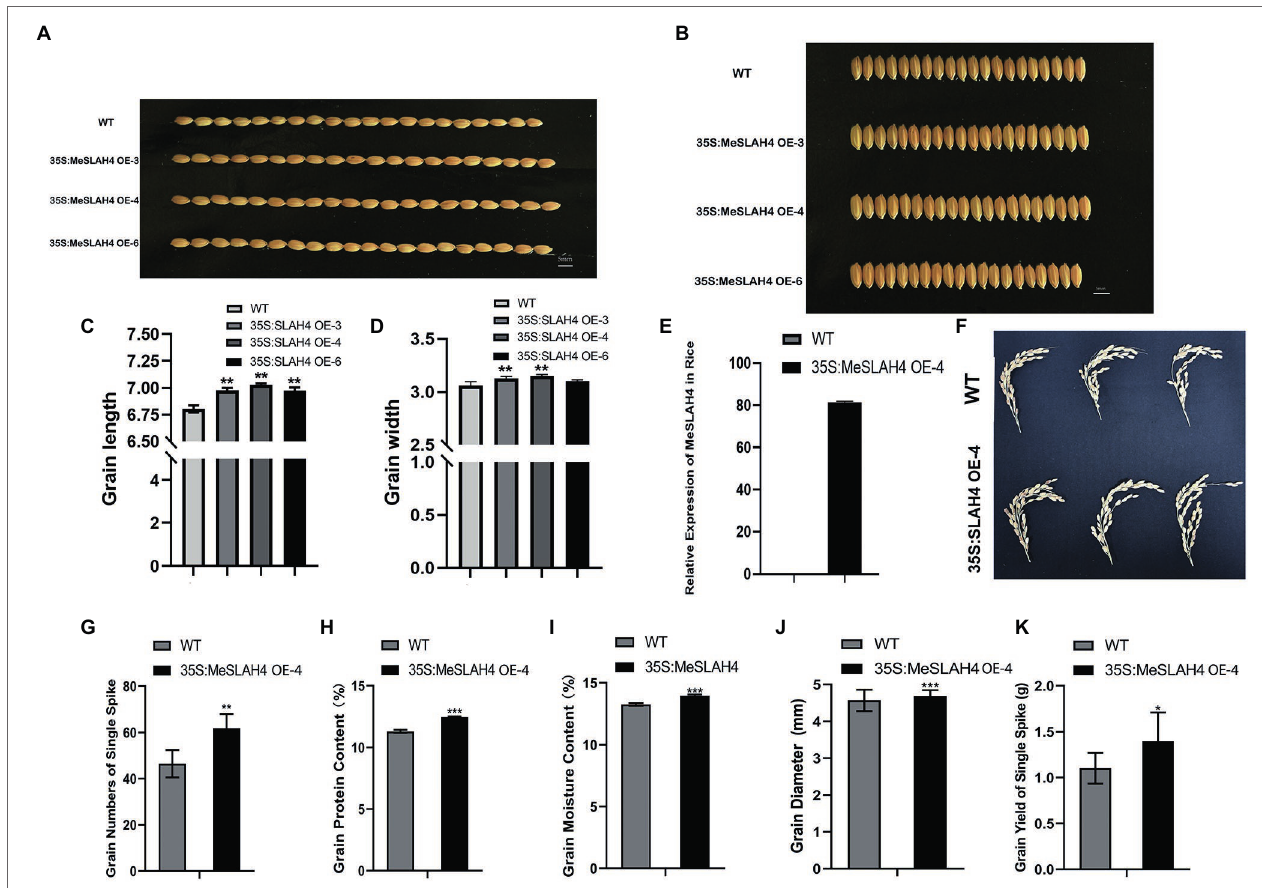
FIGURE 5 | Morpho-physiological traits of grains and relative expression of 35S:MeSLAH4 gene in the experimental lines. (A,C) grain length (mm). (B,D) grain breadth (mm). Bar = 5.0 mm. (E) Relative expression of the 35S:MeSLAH4OE4 line related to OsActin gene. (F) Panicle morphology. (G) grain numbers on a